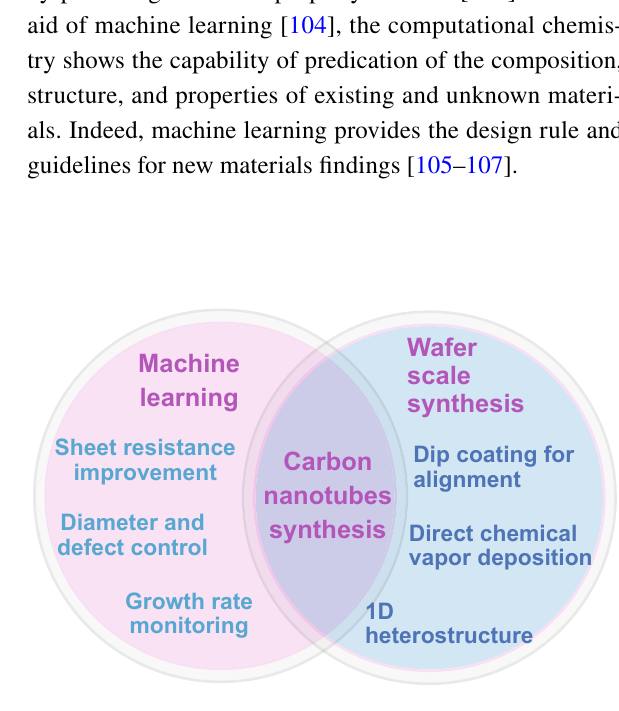
Fig. 3 The upcoming machine learning algorithms for obtaining the properties, quality, and growth rate of carbon nanotube synthesis as well as the target of wafer-scale carbon nanotube